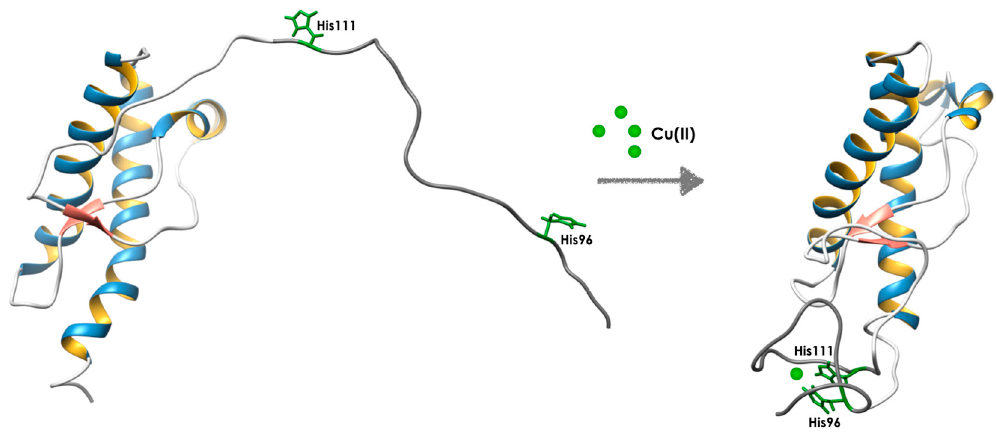
Figure 2. Cartoon representation of the structural rearrangement of PrP C structure induced by Cu(II)-binding to the non-OR region involving the His96 and His111 residues [140] .